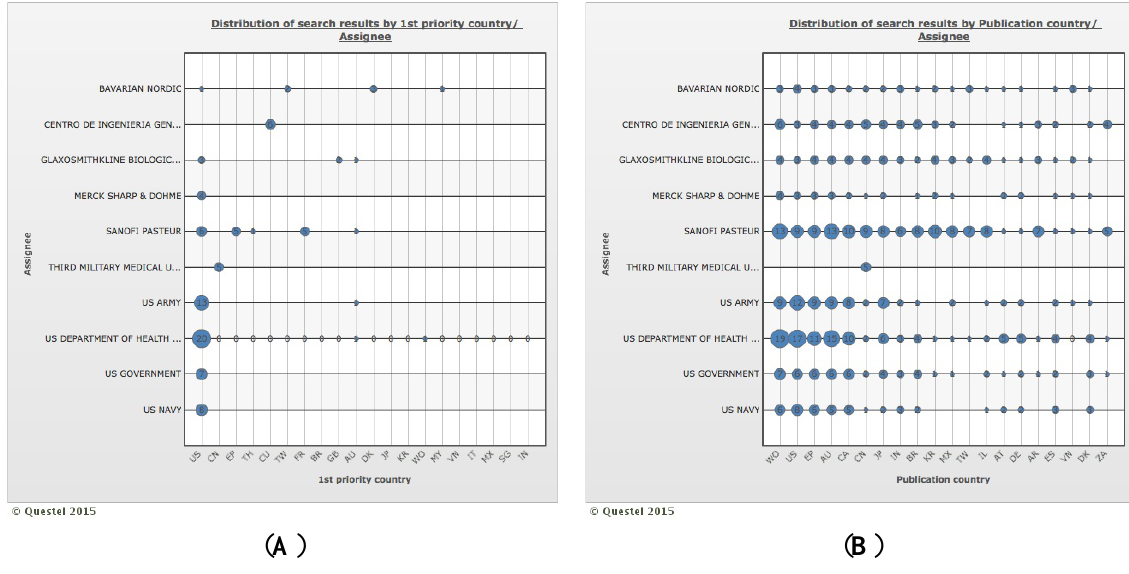
Figure 7. Distribution of search results by the correlation between top 10 holders and priority country (part A ) and publication country (part B ). Holders: Bavarian Nordic, Centro